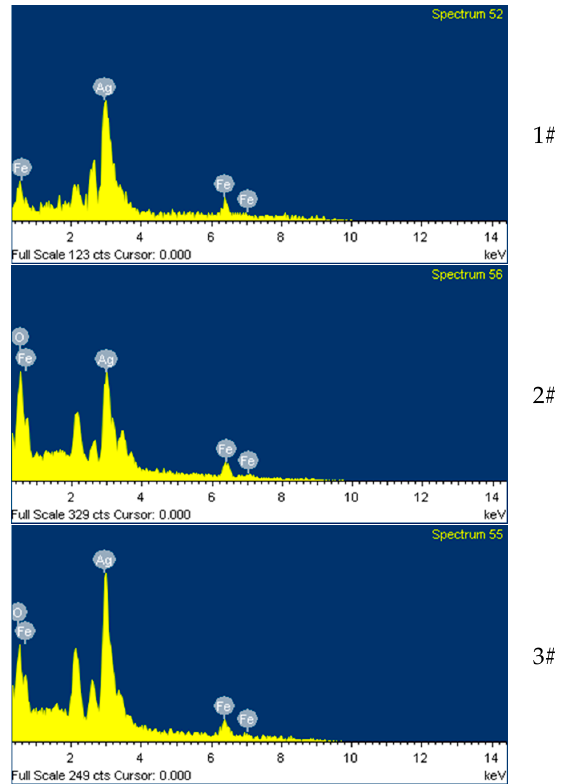
Figure 1. Typical scanning electron microscopy (SEM) images of the samples: ( A ) silk fiber; ( B ) Fe 3 O 4 –silk fiber; ( C ) Ag–Fe 3 O 4 –silk fiber (2#); and ( D ) Ag–Silk fiber. EDX spectra of Ag–Fe 3 O 4 –silk fibers (1#–3#).